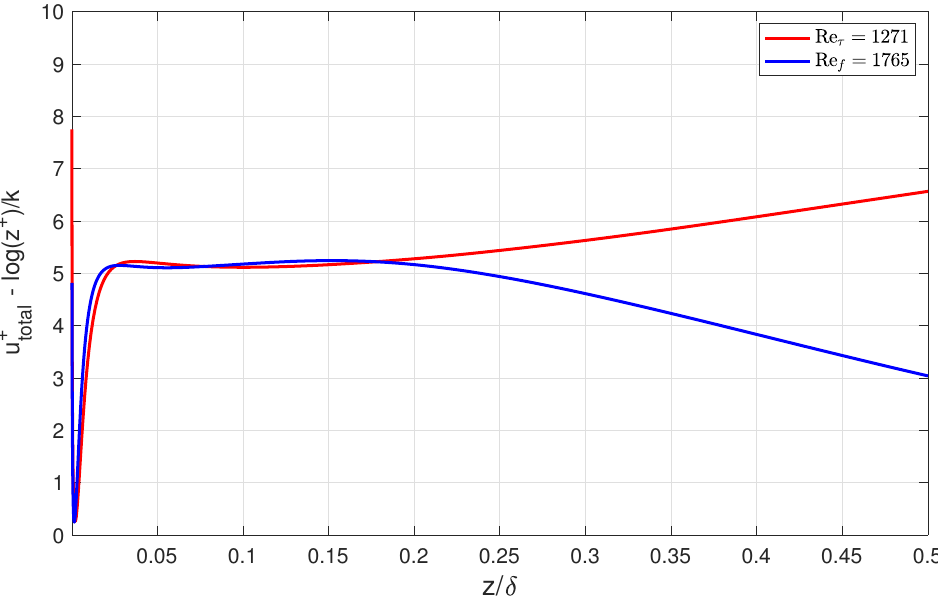
Figure 4. The difference between non-dimensional velocity in the simulations and a logarithmic function of depth ( z + ), where the relatively flat lines indicate the location of the logarithmic layer. Both the rotating and non-rotating profiles are shown